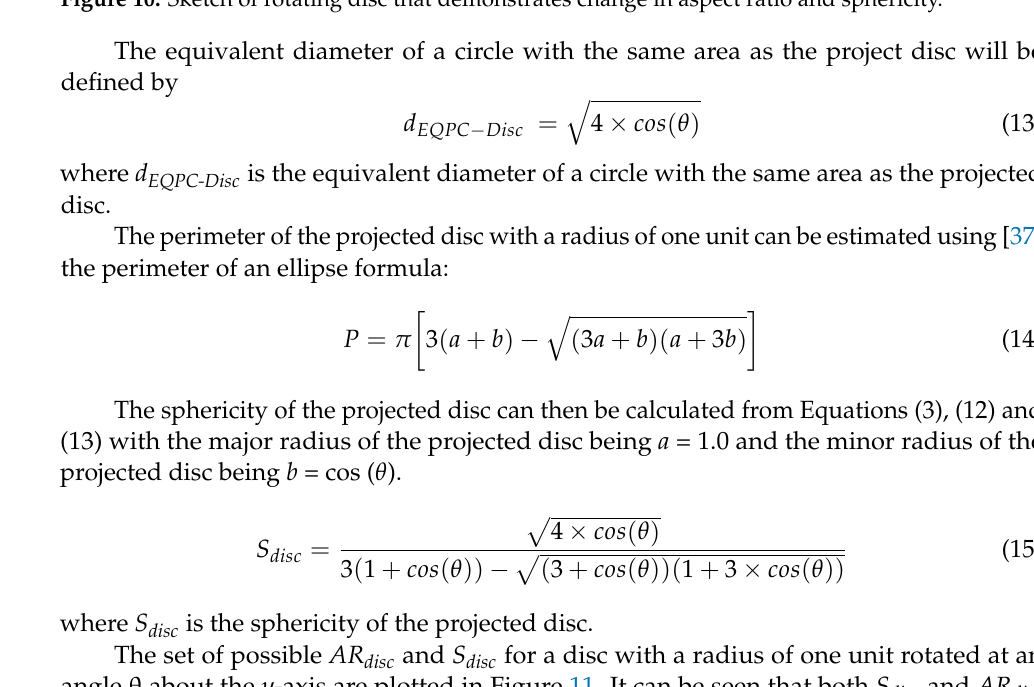
Figure 10. Sketch of rotating disc that demonstrates change in aspect ratio and sphericity.